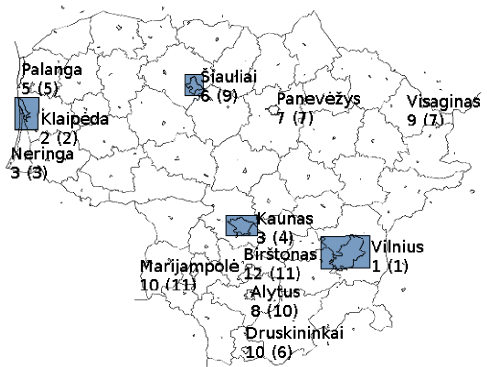
Figure 3. Ranking results of Cites Municipalities of Lithuania (made by authors according to National Land Service under the Ministry of Agriculture of the Republic of Lithuania, 2017)